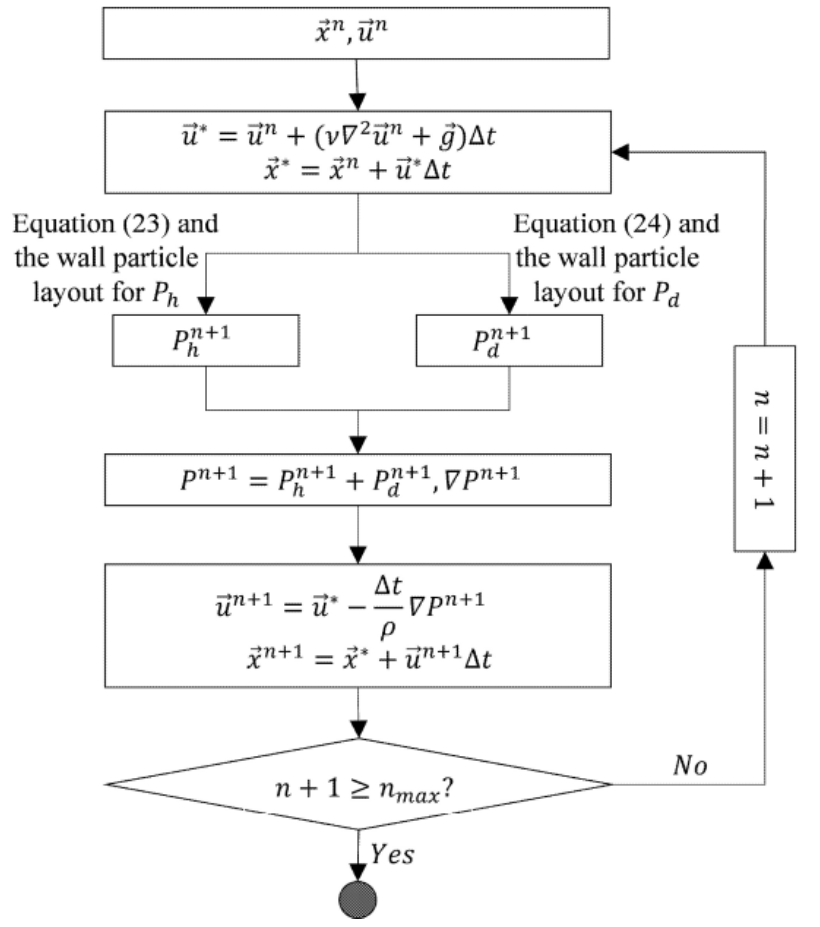
Figure 4. Simulation process of the MPS-SP scheme.